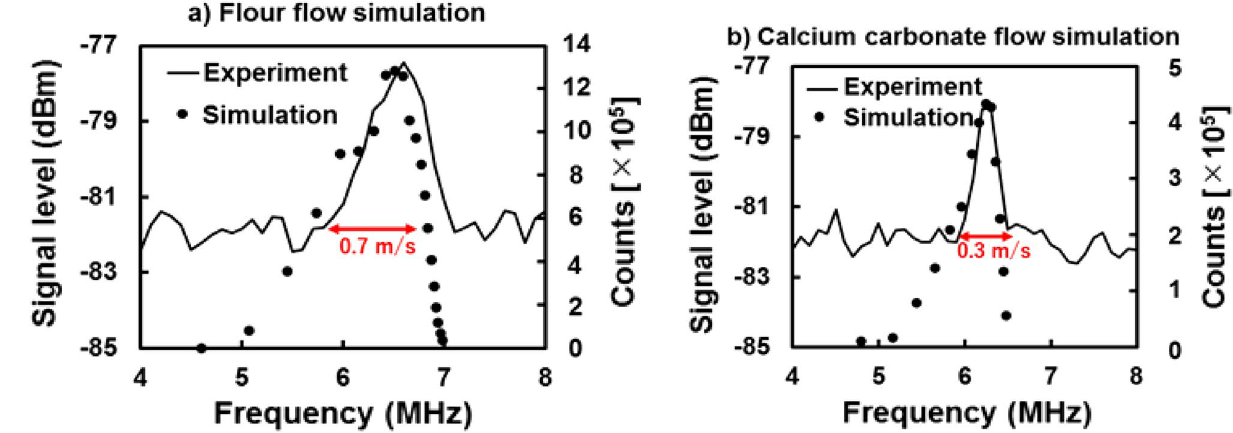
Figure 10. Doppler signal simulations of ( a ) flour and ( b ) calcium carbonate particle flow. The lefthand side vertical axis of the LCDL experiment result indicates the signal level (dBm), and the righthand vertical axis of the simulation shows the number of particles (counts). The horizontal axis is the frequency. The wind speed is simulated at 3.5 m/s (= 7